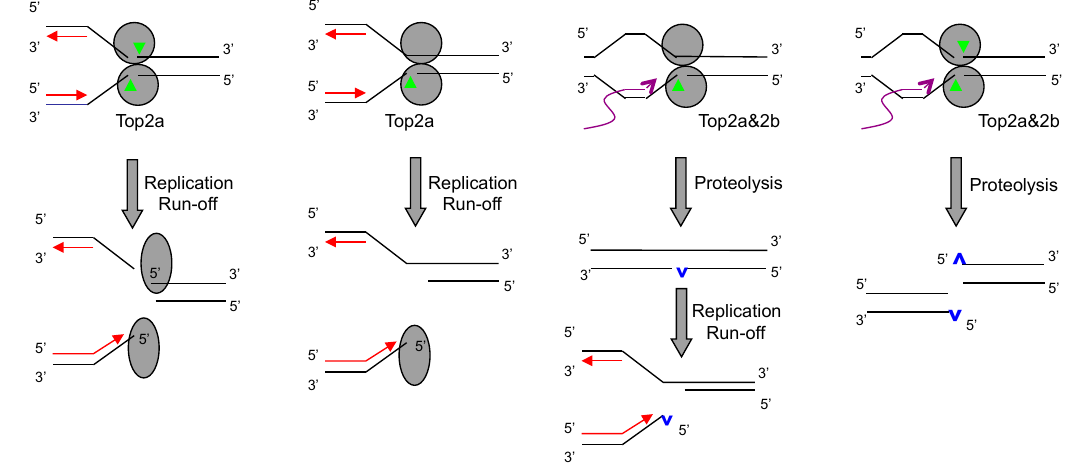
Figure 3. Model for the replication ‐ dependent and transcription ‐ dependent induction of DSBs by etoposide. Upon collision with the replication fork, ss ‐ Top2 α ccs and ds ‐ Top2 α ccs are converted into DSBs by replication run ‐ off. Upon collision with the transcription machinery, Top2ccs are degraded by the 26S proteasome, resulting in DSBs and SSBs. Unrepaired SSBs can also be converted to DSBs by replication run ‐ off.